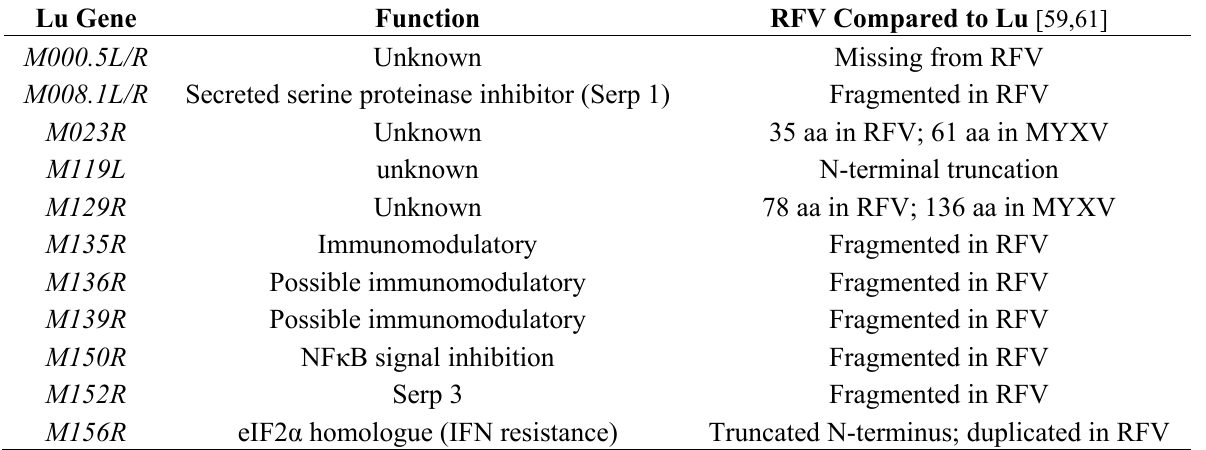
Table 3. Genes missing or substantially modified in RFV compared to